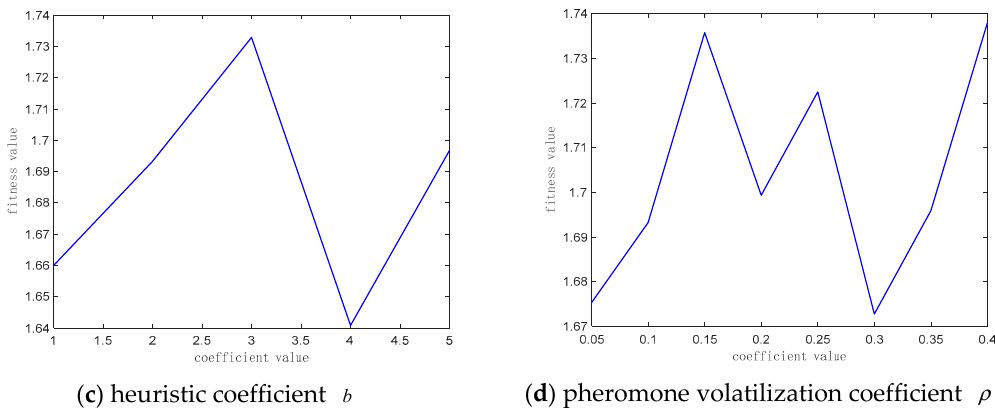
Figure 6. Optimization of parameters of ACO. ( a ) ant number; ( b ) pheromone coefficient; ( c ) heuristic coefficient; ( d ) pheromone volatilization coefficient.